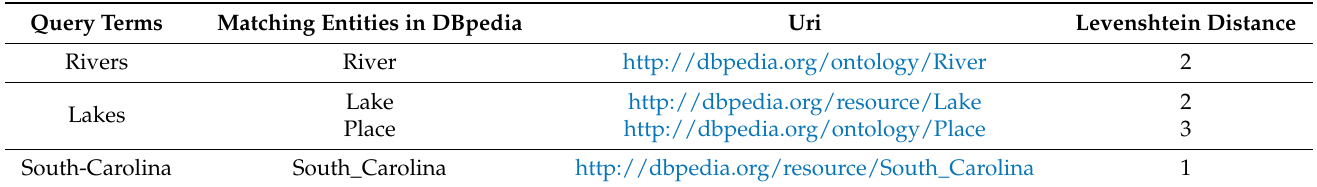
Table 1. Mapping of NL terms to DBpedia entities.